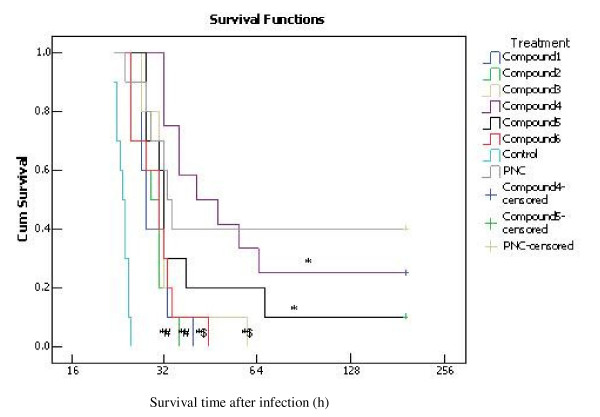
Therapeutic efficacies of each lead compound against infection with S. pneumoniae ATCC7466 in mice. Figure shows the cumulative survival (survival probability) of the mouse infection models treated differently in the following 8 days (survival time more than 8 days was censored). Data were analyzed by using the survival analysis approach (Kaplan-Meier Method). Significant treatment effects were found among the groups (P < 0.01) by an overall comparison. Pairwise comparisons revealed that compounds 1–6 prolonged survival time in mouse infection models as compared to negative control (p < 0.01), and that compound 4 and 5 were almost as effective as positive control PNC (P > 0.1), but the other compounds were less effective than it (P < 0.05 or P < 0.1). *P < 0.01 indicates significant differences as compared to negative control; #P < 0.05 and $P < 0.1 indicate significant differences as compared to positive control.